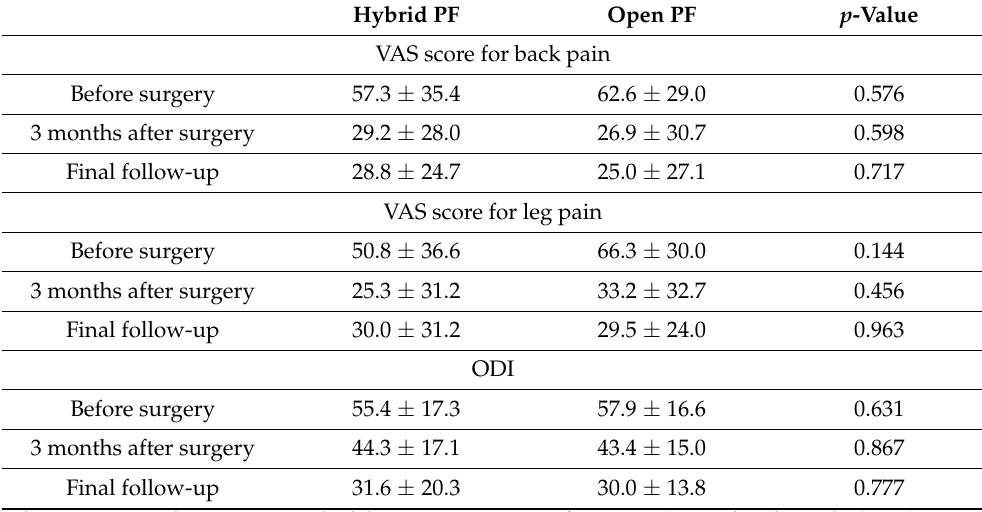
Table 3. Clinical parameters of the hybrid PF and open PF